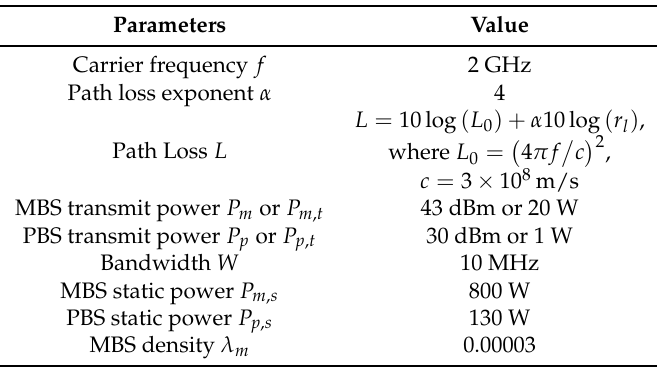
Table 1. Network scenario